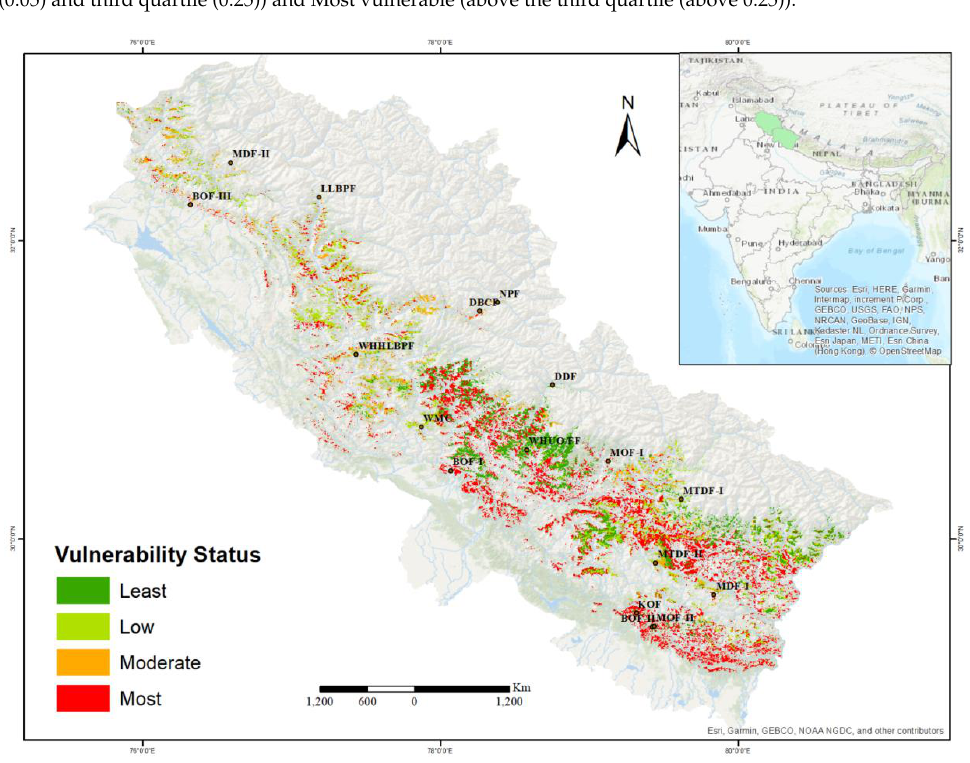
Table 3. Association between vulnerability status with elevation range and exposure level. Category